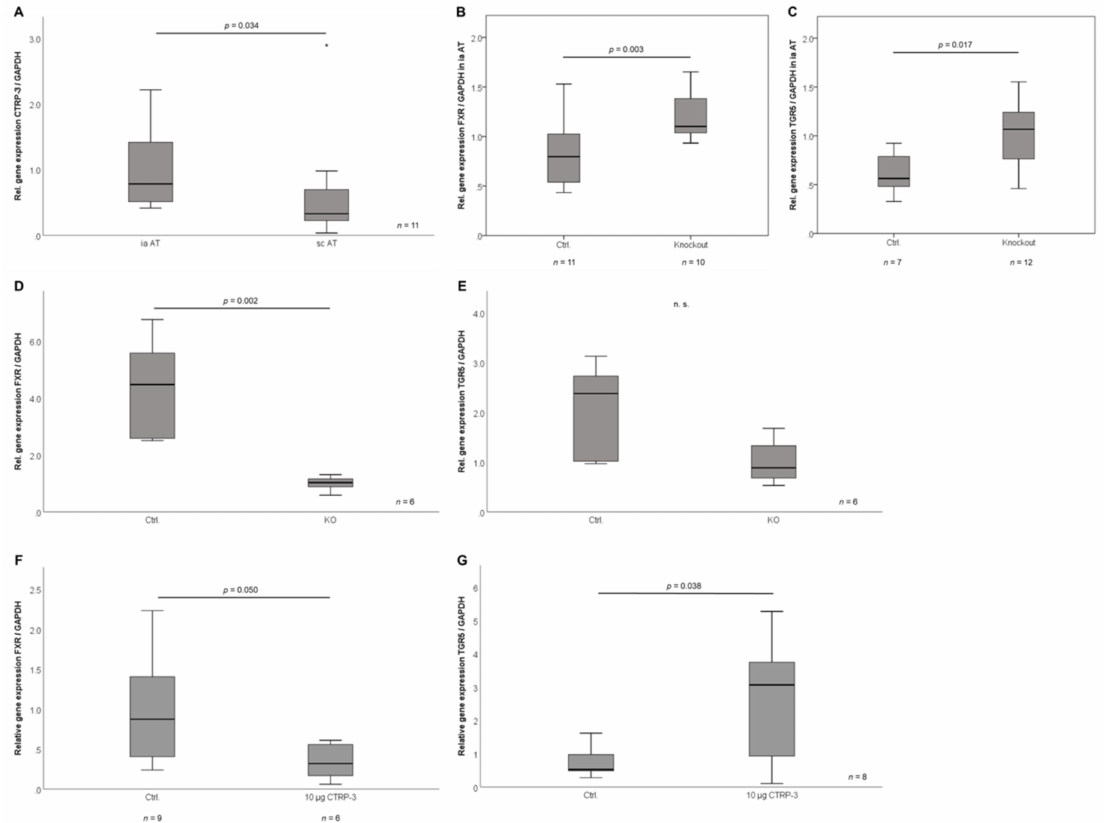
Figure 5. CTRP-3 and bile acid receptor expression in adipose tissue in murine models in vivo. CTRP-3 and bile acid receptor (FXR, TGR5) gene expression levels in murine adipose tissues and primary adipocytes (derived from adipose progenitor cells isolated from adipose tissue) were analyzed by RT-PCR. AT, adipose tissue; ia, intra-abdominal; Ctrl., control mice; FXR, farnesoid x receptor; GAPDH, glyceraldehyde-3-phosphate dehydrogenase; sc, subcutaneous; KO, adipocyte-specific CTRP-3 knock out mice; TGR5, G-protein coupled bile acid receptor. ( A ) CTRP-3 mRNA levels in intra-abdominal and in subcutaneous AT of wildtype mice (C57BL / 6J; age 6 months; n = 11). ( B ) Elevated gene expression of FXR in intra-abdominal AT of CTRP-3 knockout mice (age 6 months; n = 10–11). ( C ) Elevated gene expression of TGR5 in intra-abdominal AT of CTRP-3 knockout mice (age 6 months; n = 7–12). ( D ) Decreased gene expression of FXR in primary adipocytes derived from subcutaneous AT of CTRP-3 knockout mice ( n = 6). ( E ) TGR5 gene expression in primary adipocytes derived from subcutaneous AT of CTRP-3 knockout mice ( n = 6). ( F ) Downregulation of FXR gene expression in intra-abdominal AT of wildtype mice (C57BL / 6J; age 10 weeks; n = 5–9) by intraperitoneal injection of recombinant CTRP-3. ( G ) Induction of TGR5 gene expression in intra-abdominal AT of wildtype mice (C57BL / 6J; age 10 weeks; n = 5–9) by intraperitoneal injection of recombinant